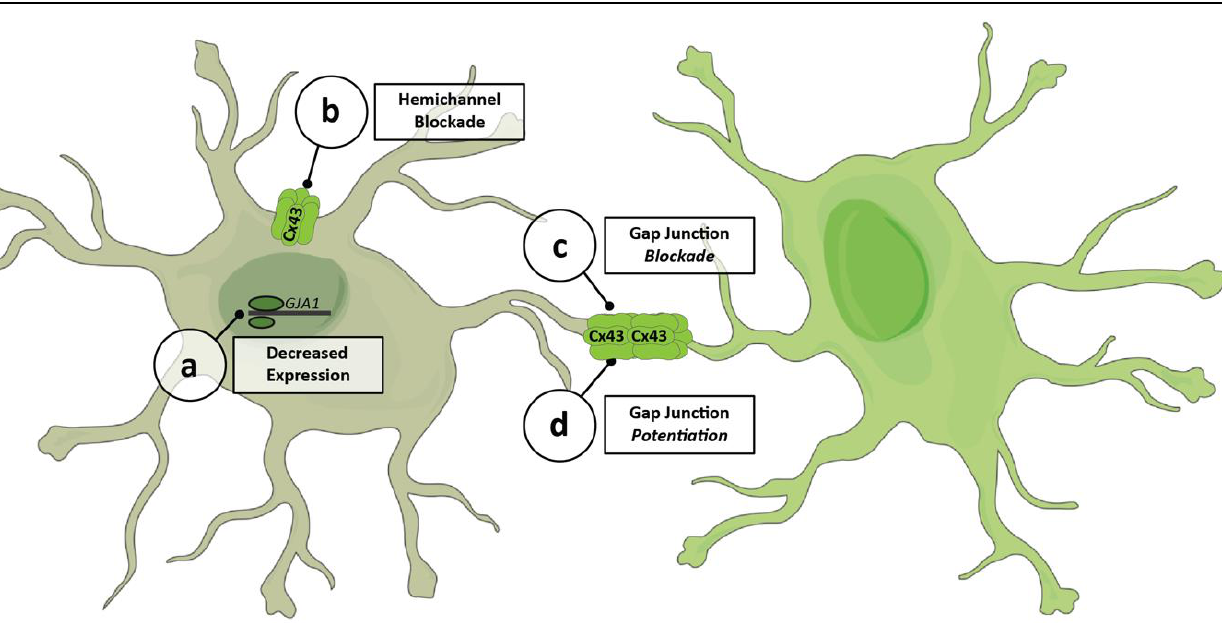
Figure 3. Mechanisms for targeting Cx43 mediated astrocytic networks. Modulation of Cx43 physiology can occur at multiple levels. Substances may decrease the level of expression of Cx43 ( a ), limiting the production and assembly of both gap junctions and hemichannels. Others may directly target one of these functional structures. Some seek to decrease hemichannel activity by selectively blocking Cx43 hemichannels ( b ). Often, agents may directly decrease the degree of gap junctional coupling between adjacent cells ( c ). Other recent drugs have sought to increase the degree of coupling at Cx43 gap junctions ( d ). Cx43, connexin-43; GJA1, gene encoding Cx43, gap junction alpha-1.